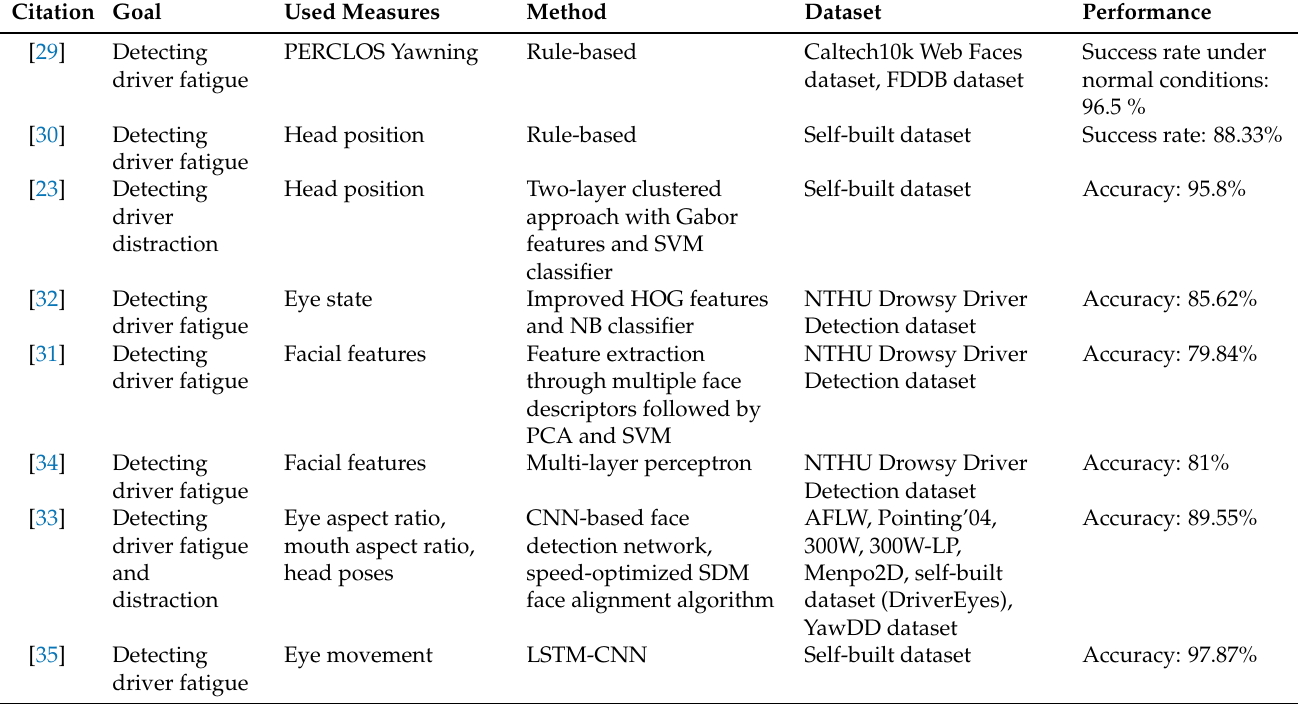
Table 1. Summary of the literature